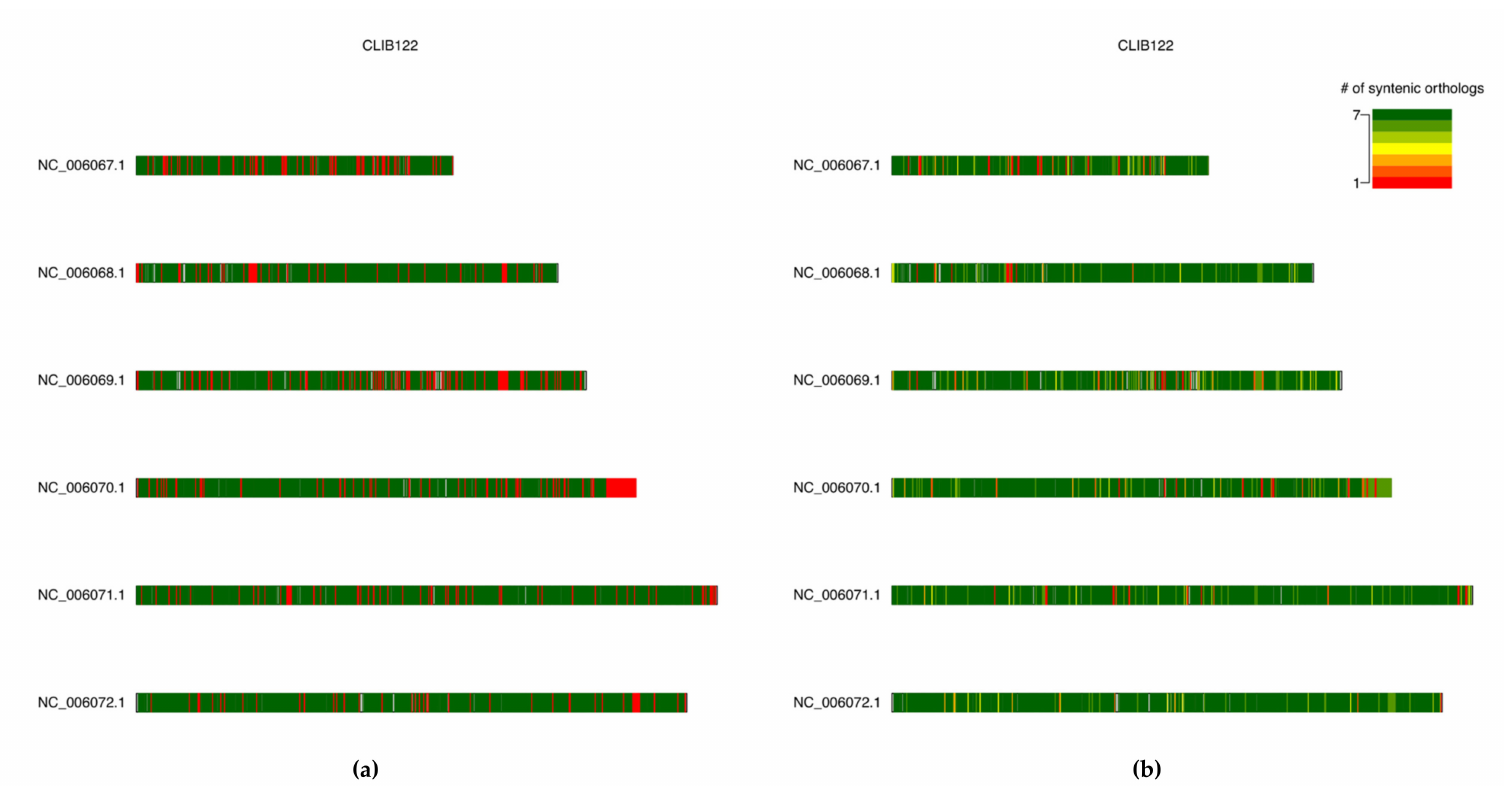
Figure 5. Karyotype plots of core and accessory gene model locations across the six chromosomes of Yarrowia lipolytica strain CLIB122. Left: ( a ) Gene model locations coloured by source pan-genome component (core: green, accessory: red). Right: ( b ) Gene model locations coloured by the size of their source syntenic cluster. Non-coding regions coloured in grey. Both figures generated by